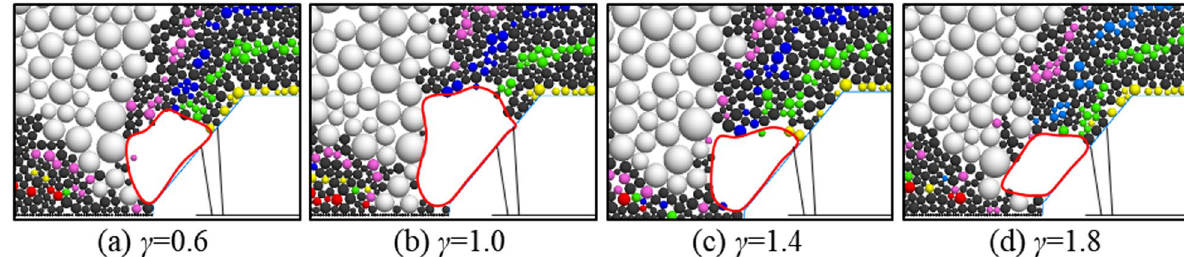
I , b S II , and c S III